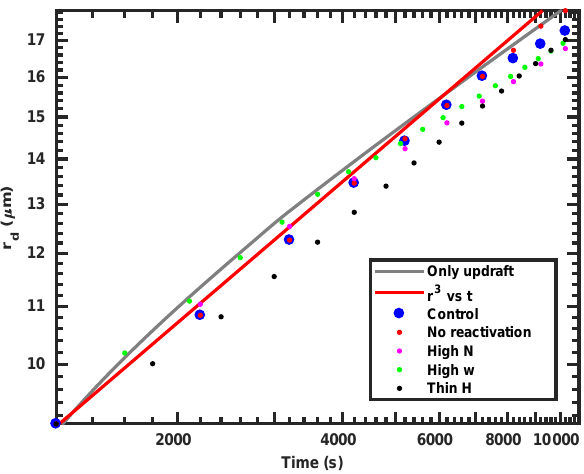
Figure 9. Changes of the environmental saturation ratio (gray) and the equilibrium saturation ratios over two droplets (red and blue) with time in an oscillating parcel. The blue line is for a droplet formed on a dry aerosol with radius of 53nm and the red line is for a droplet formed on a dry aerosol with radius of 503nm. The smaller cloud droplet (formed on a dry aerosol with radius of 53nm) deacti- vates at approximately 1 . 5h and reactivates at approximately 2 .